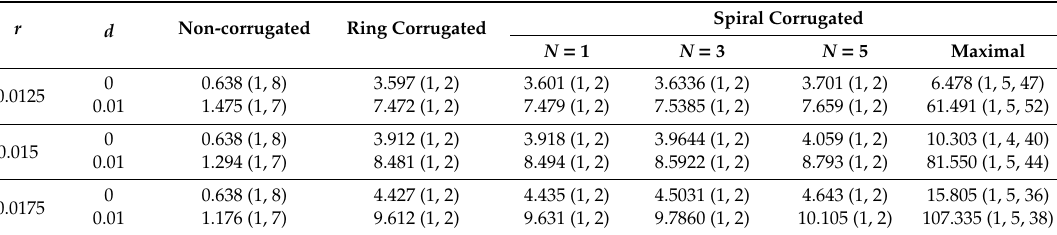
Table 4. The critical buckling pressure of corrugated sandwich FGM cylindrical shells with di ff erent